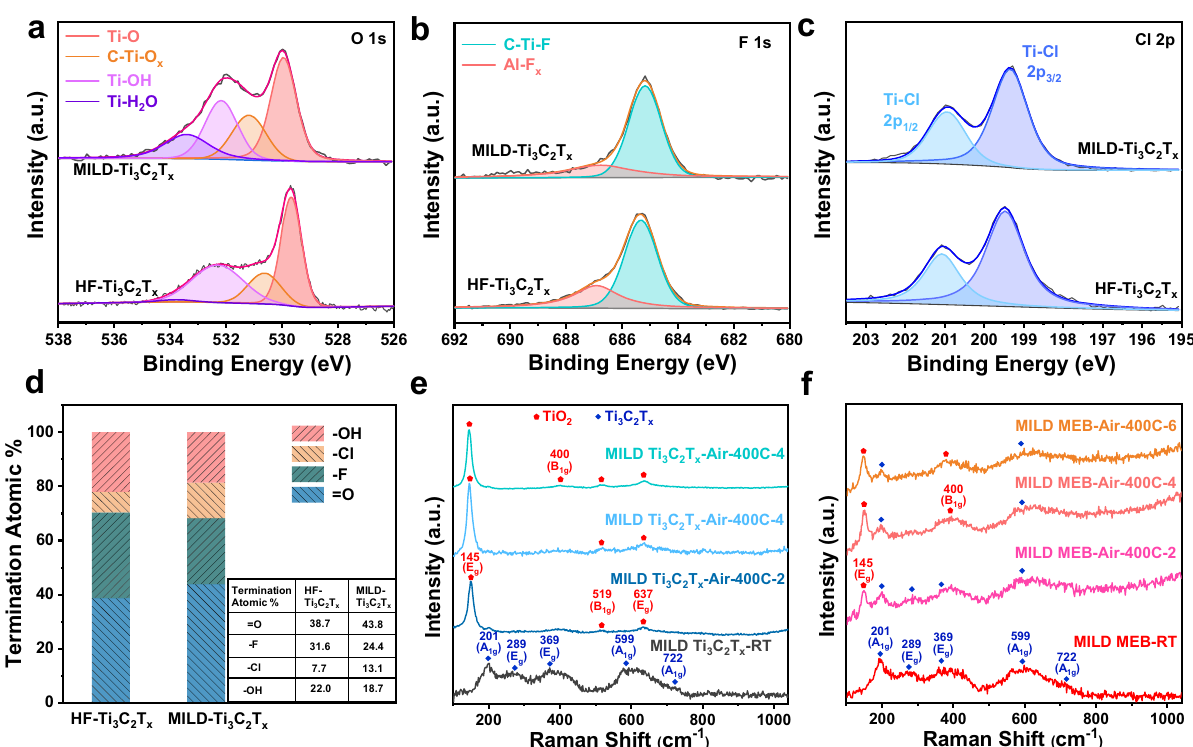
Fig. 4 | Different termination ratios of MILD-Ti3C2T x and HF-Ti3C2T x , and high-temperature resistant property of MILD MEB with the presence of oxy- gen.a – c XPSofO1 s ,F1 s ,andCl2 p signals,respectively,forthepristineHF-Ti 3 C 2 T x and MILD-Ti 3 C 2 T x fi lms. d The termination ratio of HF-Ti 3 C 2 T x and MILD-Ti 3 C 2 T x